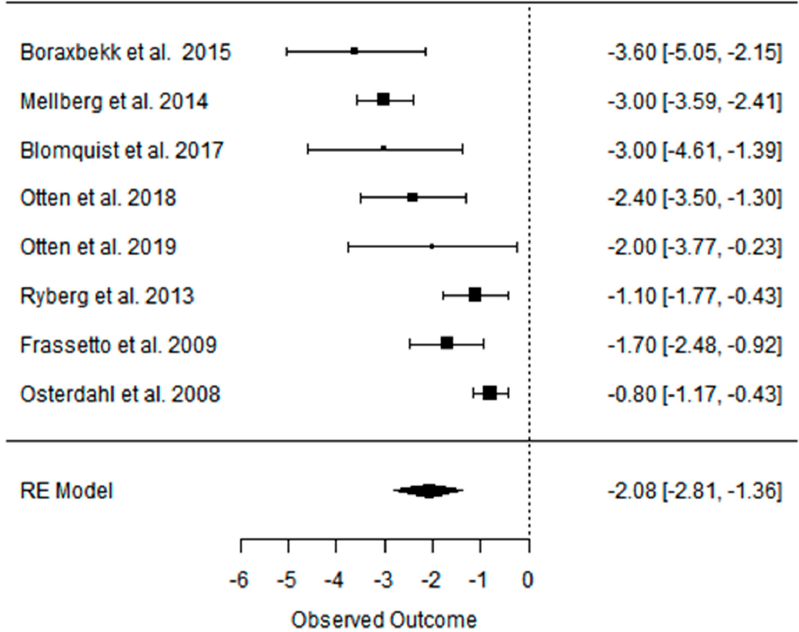
Figure A4. Forest plot of the effect of a PDs on BMI in the short term (weighted mean difference).